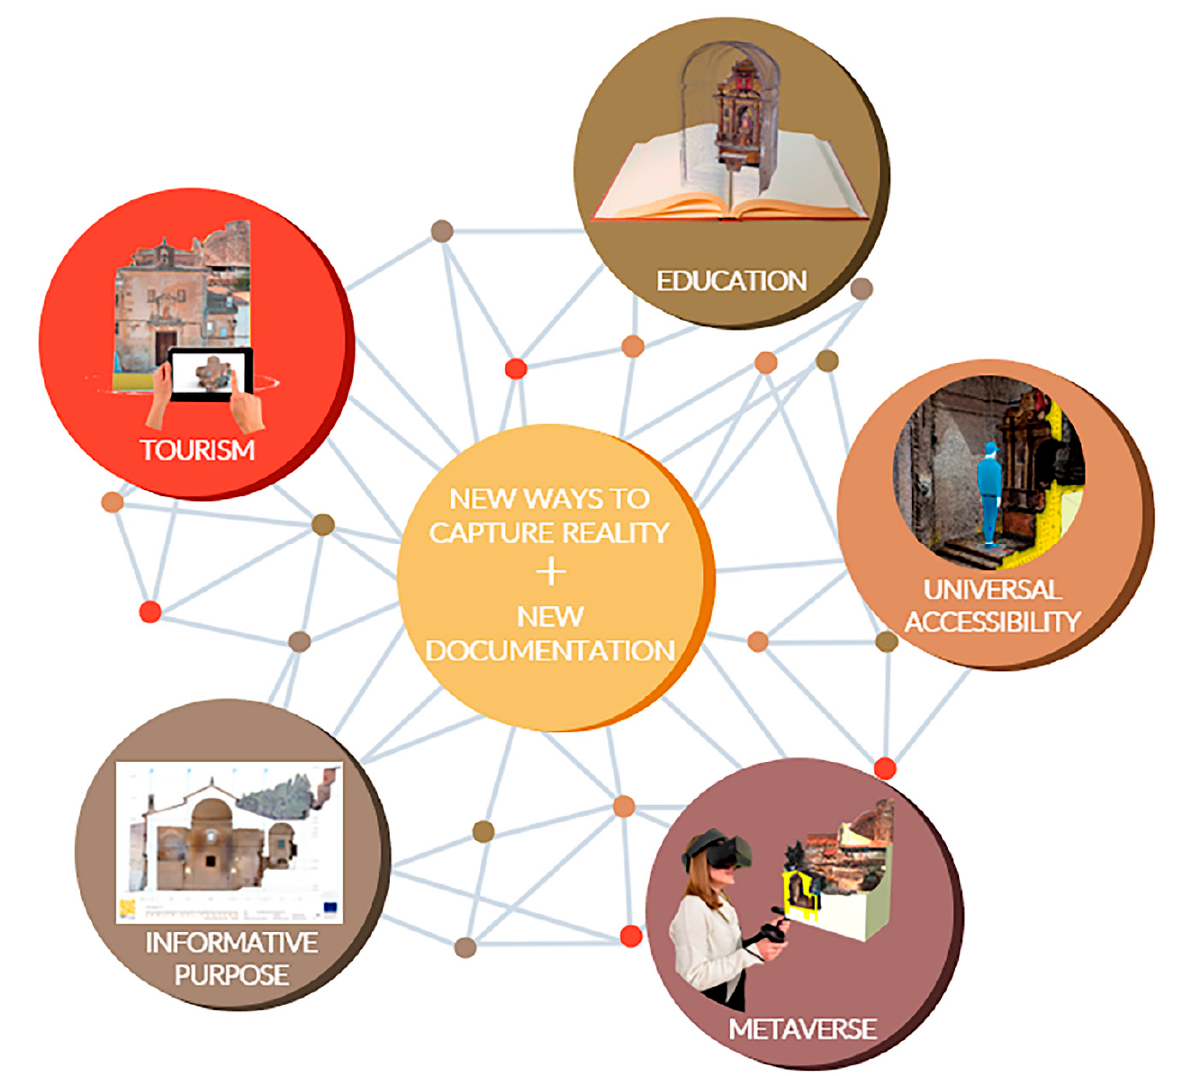
Figure 27. New functionalities based on the new digital documentation.